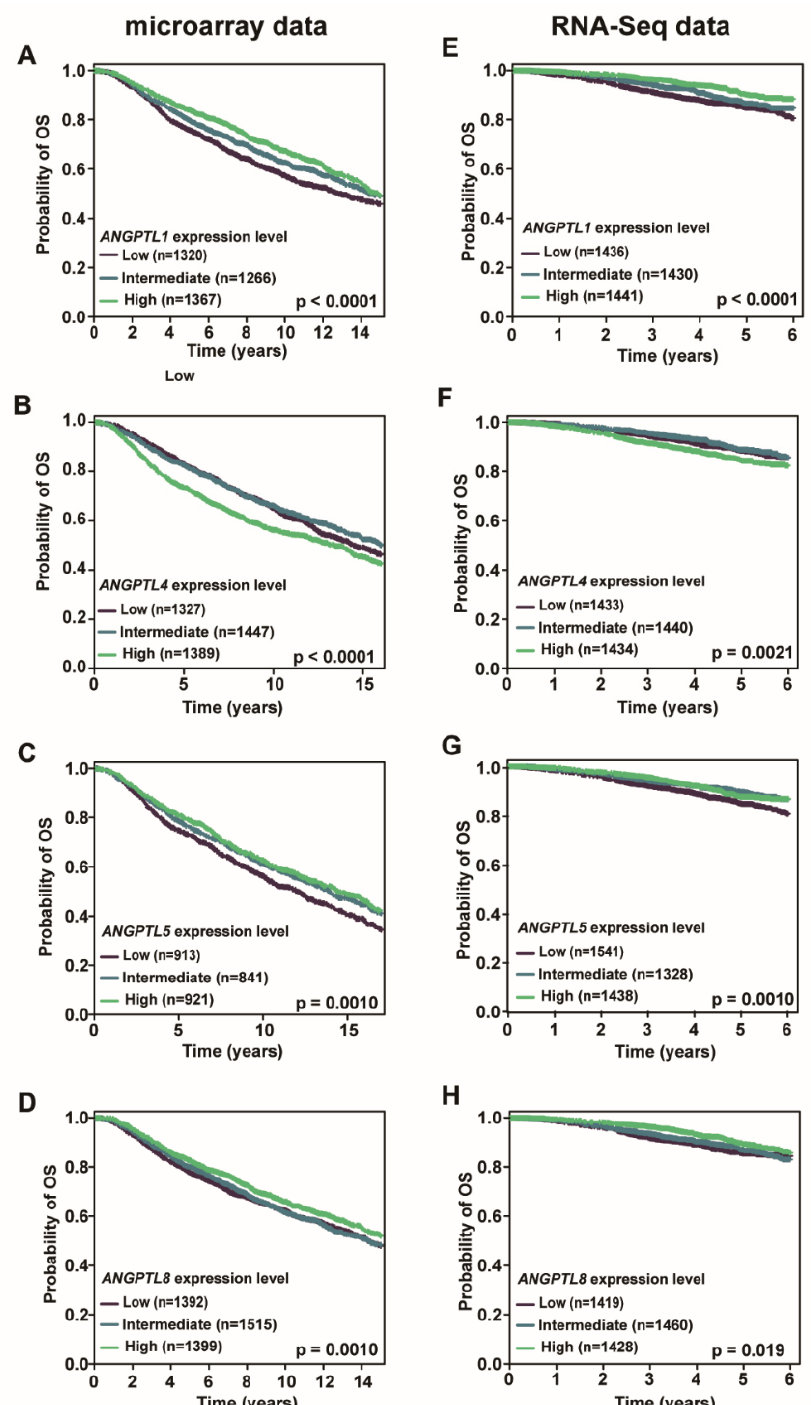
Figure 3. Association between ANGPT / ANGPTL genes and overall survival (OS) in breast cancer patients. Transcriptional levels of ANGPTL1 , 4 , 5 , and 8 are significantly associated with OS in BC patients in both microarray ( A – D ) and RNA-seq ( E – H ) data. ( A , E ) ANGPTL1 . ( B , F ) ANGPTL4. ( C , G ) ANGPTL5. ( D , H ) ANGPTL8